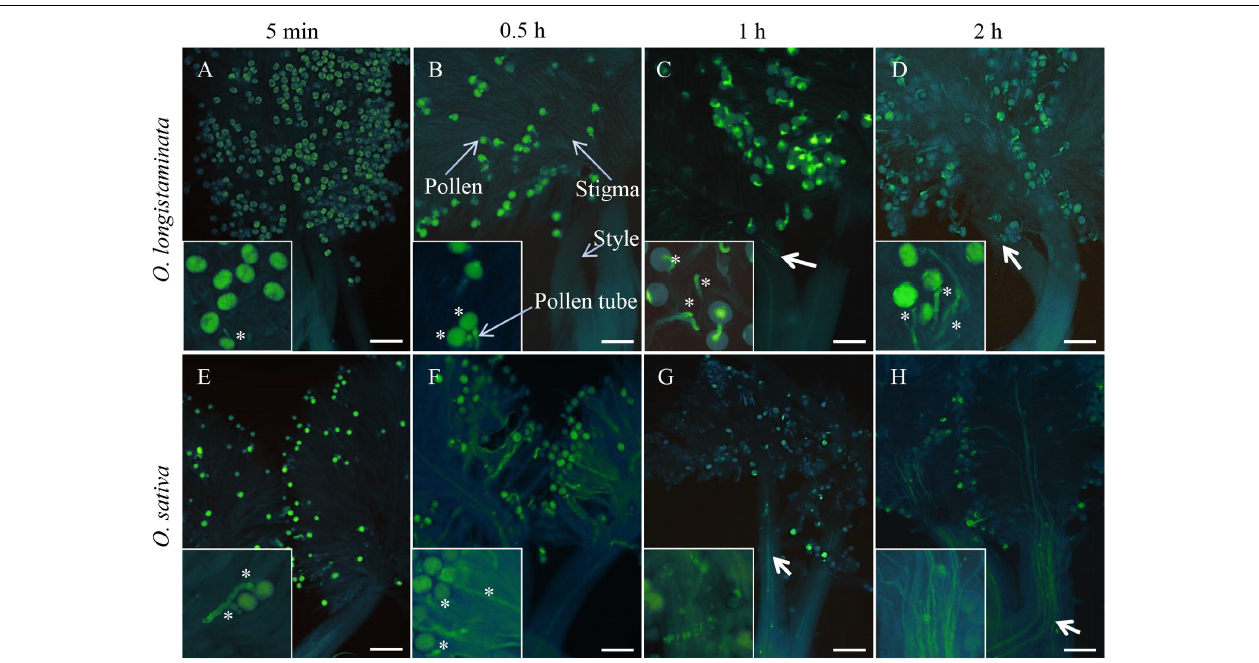
FIGURE 1 | Pollen germination of Oryza longistaminata and Oryza sativa . (A–D) Self-pollination of O. longistaminata : (A) The pistils of self-pollinated OlMK68 after 5 min, stained with aniline blue solution. (B) The majority of pollen grains had germinated at 0.5 h following self-pollination. (C) The pollen tube reached the top of the style at 1 h after self-pollination. (D) At 2 h after pollination, the pollen tube remained on top of the style and appeared incapable of passing through the style. (E–H) Self-pollination of O. sativa : (E) Pollen began to germinate 5 min after self-pollination. (F) The pollen tube began to elongate at 0.5 h after self-pollination and passed through the style within 1–2 h following cross-pollination (G,H) . Bar = 50 µ m. The asterisk indicates the germination of pollen grains. Bold arrows indicate pollen tubes in the